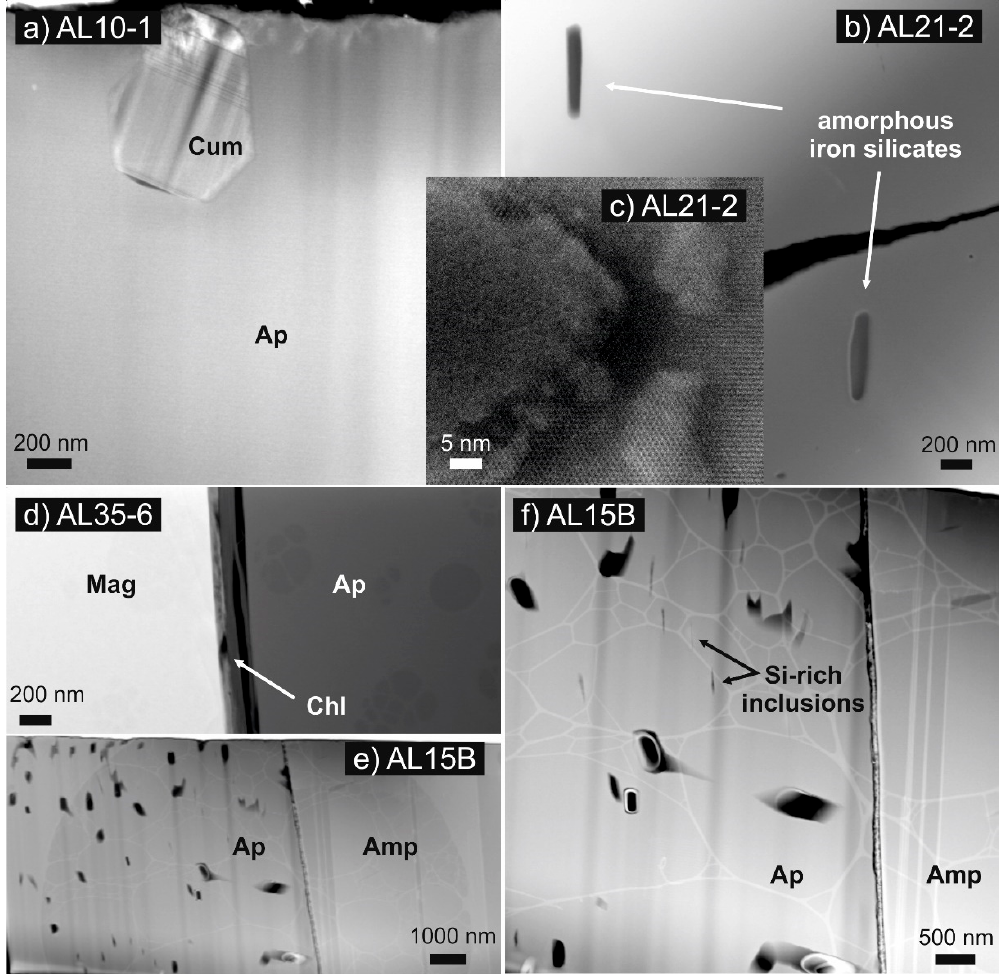
Figure 3. ( a ) An overview HAADF image of cummingtonite (Cum) inclusion in hydroxylapatite (Ap) from BIF AL10-1; ( b ) a HAADF image and ( c ) lattice fringe image of elongated amorphous iron silicate inclusions in hydroxylapatite from mafic dyke AL21-2; ( d ) a HAADF image of a chlorite-filled zone (Chl) between magnetite (Mag) and hydroxylapatite (Ap) crystals in BIF AL35-6; ( e – f ) overview HAADF images of abundant nanopores and elongated Si-rich inclusions in fluorapatite from BIF AL15B. Note the rough crystal boundary between fluorapatite (Ap) and amphibole (Amp). The white lines represent the perforated carbon film on which the foil is resting.